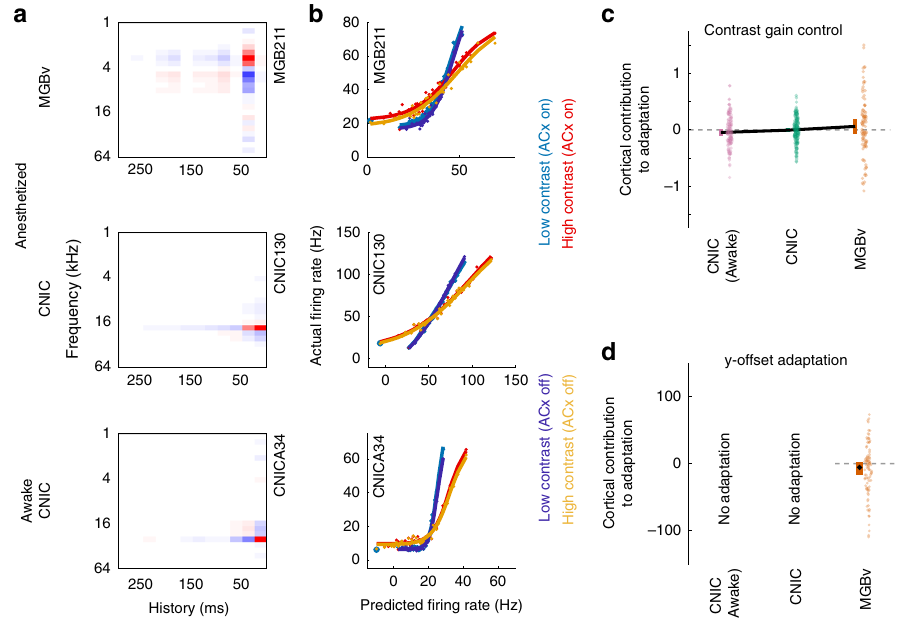
Fig. 5 Contrast adaptation in the CNIC and MGBv is unaffected by silencing of auditory cortex. a Examples of spectro-temporal receptive fi elds of units recorded in MGBv and CNIC of anesthetized mice and in CNIC of awake mice (red: positive, white: 0, blue: negative). b The output nonlinearities of the same units during high- and low-contrast stimulation, with or without silencing of cortex. c Summary of effects of cortical silencing on contrast gain control in units recorded in MGBv and CNIC of anesthetized mice and CNIC of awake mice; this was quanti fi ed as the % gain change with cortex silenced minus the % gain change with cortex intact. d Summary of effects of cortical silencing on contrast-dependent y-offset adaptation in the MGBv; this was quanti fi ed as % adaptation with cortex silenced minus % adaptation with cortex intact. No contrast-dependent y-offset changes were observed in the CNIC, so the effects of cortical silencing are not shown. c , d Colored error bars, 95% bootstrapped non-parametric con fi dence intervals around the medians (individual data points (excluding outliers) are displayed next to the corresponding error bars). Source data for c , d are provided as a Source Data fi (Dunn – Sidak corrected) demonstrating signi fi cantly longer median adaptation times from CNIC to MGBv ( p < 0.05) and from MGBv to A1 ( p < 0.05) (Fig. 6b).